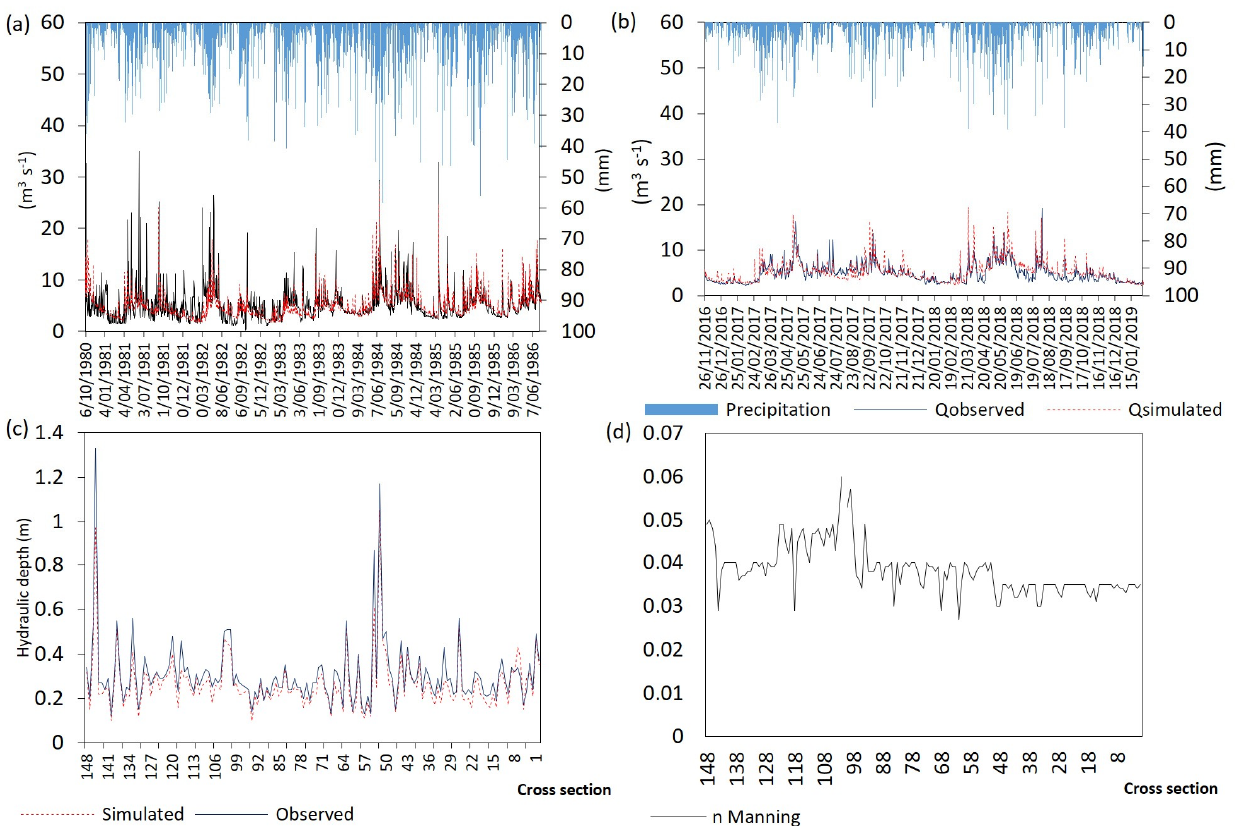
Figure 2. Hydrological modeling: ( a ) calibration period: 1984–1985, ( b ) validation period: 2017–2018, ( c ) hydraulic model calibration, ( d ) Manning’s n coefficient values adopted in the simulated stream reach.